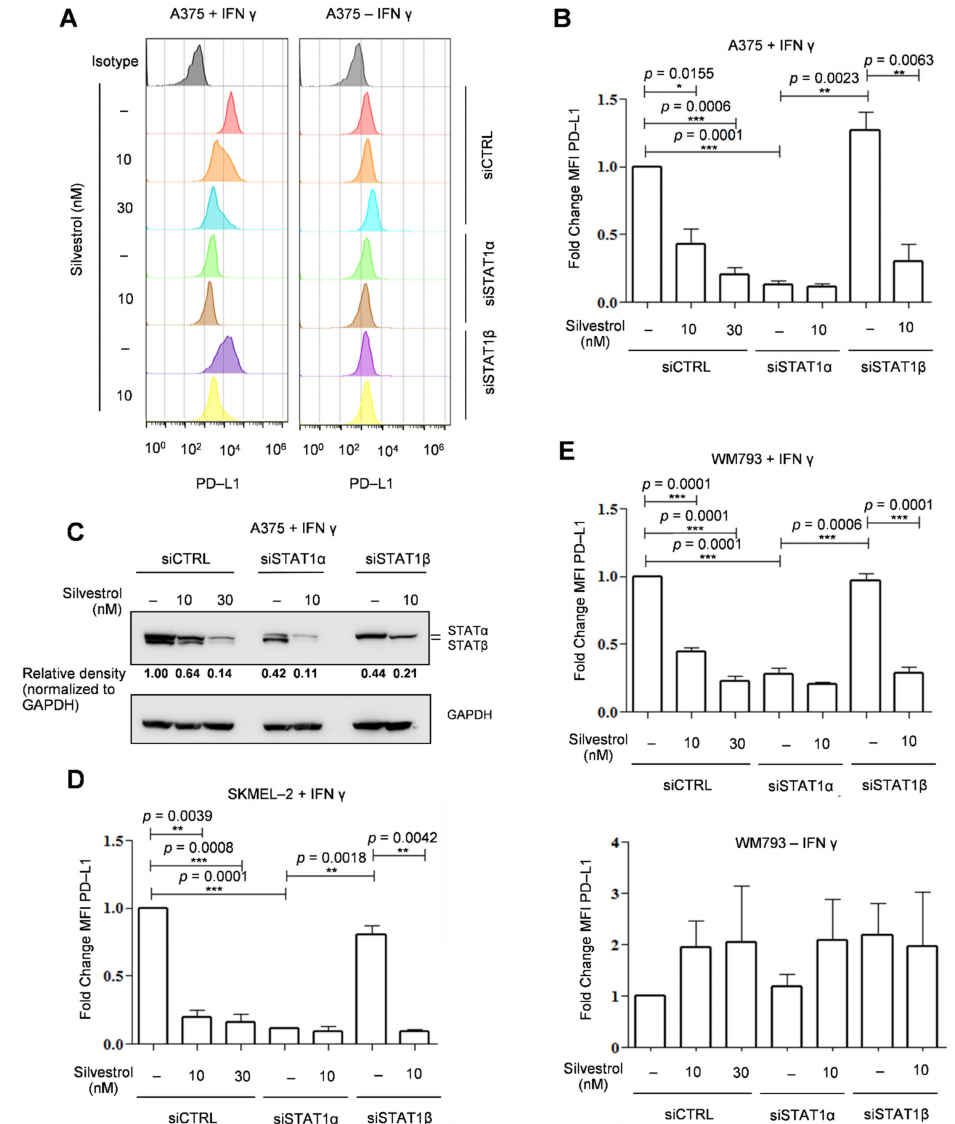
Figure 1. Functional importance of APA-generated STAT1 protein isoforms on PD-L1 gene expression. ( A ) PD-L1 was visualized by flow cytometry in A375 melanoma cells treated with IFN- γ (100 ng/mL) and silvestrol (10 nM or 30 nM); ( B ) PD-L1 mean fluorescence intensity (MFI) quantification in A375. The data are presented as the mean ± s.e.m. ( n = 3 independent experiments). p -values were calculated using two-tailed unpaired t -test. Statistical analyses were performed for all data, p -values are indicated exclusively in the case of statistical significance; (* p ≤ 0.05, ** p ≤ 0.01, *** p ≤ 0.001) ( C ) Western blot analysis of the indicated proteins in A375. Quantification of STAT1 expression was performed by calculating the relative densities normalized to GAPDH levels (uncropped western blot original images see Figure S8). ( D ) same as ( B ) in SKMEL-2 ( E ) same as ( B ) in WM793 with (top) or without (bottom) IFN- γ